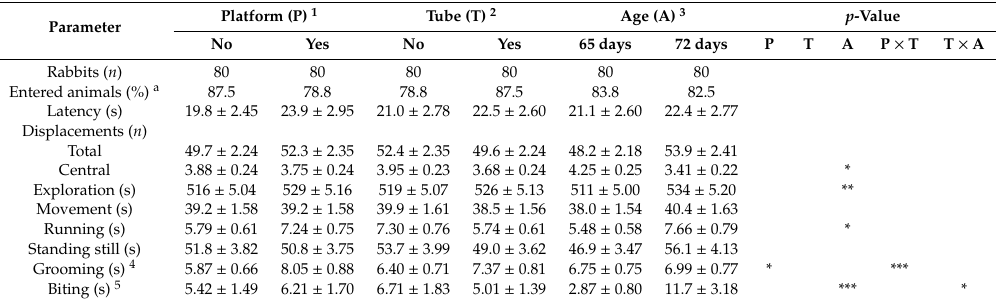
Table 5. E ff ects of enrichment (platform or tube) and age (65 days and 72 days) on the reactivity (least square means ± standard errors) of rabbits during the open-field